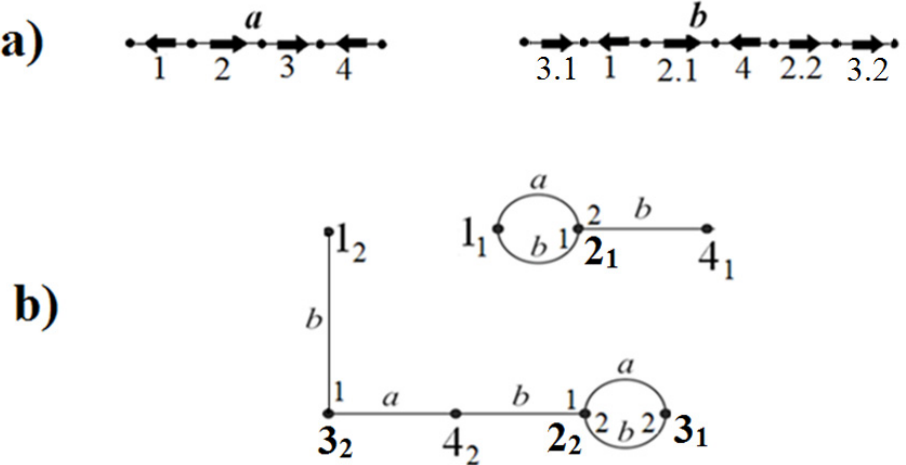
Figure 1. ( a ) Structures a and b : in b , edges with names 2 and 3 are repeated twice: as 2.1 and 2.2, and as 3.1 and 3.2. ( b ) Corresponding graph a + b of < a , b >. Names of paralogic vertices are displayed in bold.